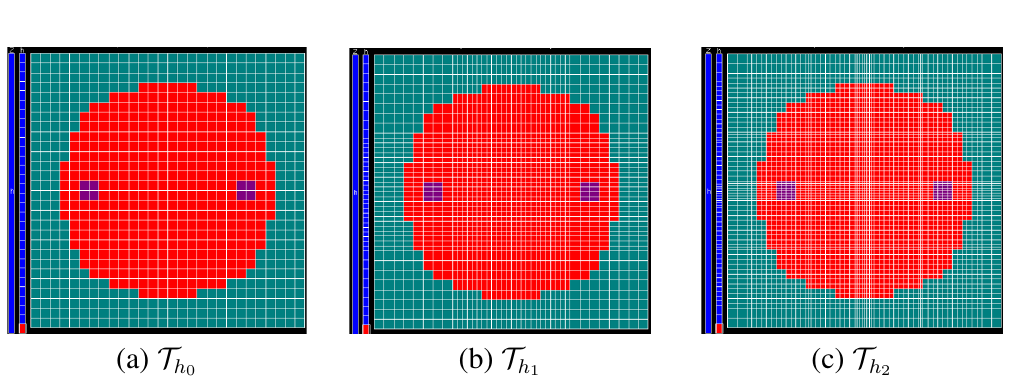
Figure 3: Adaptive meshes with direction marker